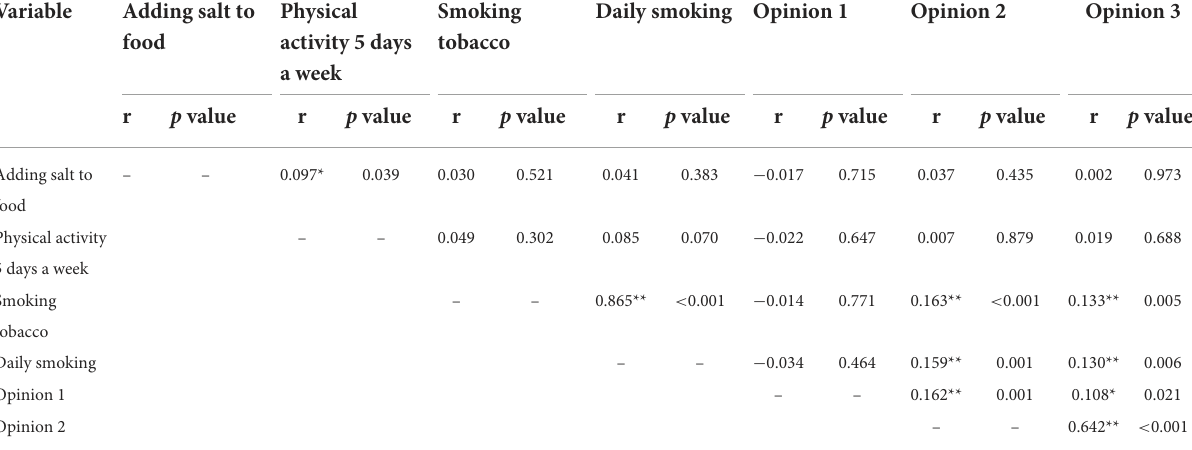
TABLE 6 Pearson correlation between opinions with smoking, physical activity, and salt addition to food. Variable Adding salt